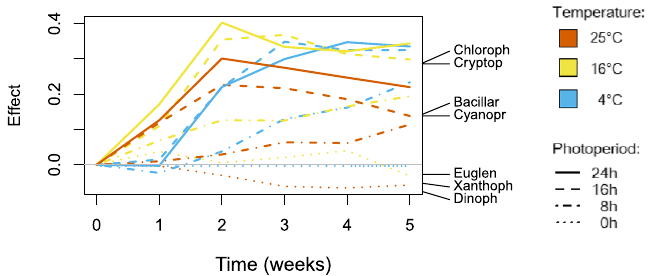
Figure 5. Principal response curves (PRC) illustrating changes over time in the structure of the phytoplankton communities in particular experimental treatments. Secondary axis (right): first canonical axis of the Redundancy Analysis performed on the abundances of particular taxonomical groups. The graph was created in R 4.0.4 under RStudio 1.4.1106 using the ‘vegan’ package and the data in S1. Phytoplankton taxonomic groups/ abbreviations: Cyanopr - Cyanoprokaryota (cyanobacteria), Chloroph - Chlorophyta (chlorophytes), Cryptop - Cryptophyta (cryptophytes), Bacillar - Bacillariophyceae (diatoms), Euglen - Euglenophyta (euglenoids), Dinoph - Dinophyceae (dinoflagellates), Xanthoph - Xanthophyceae